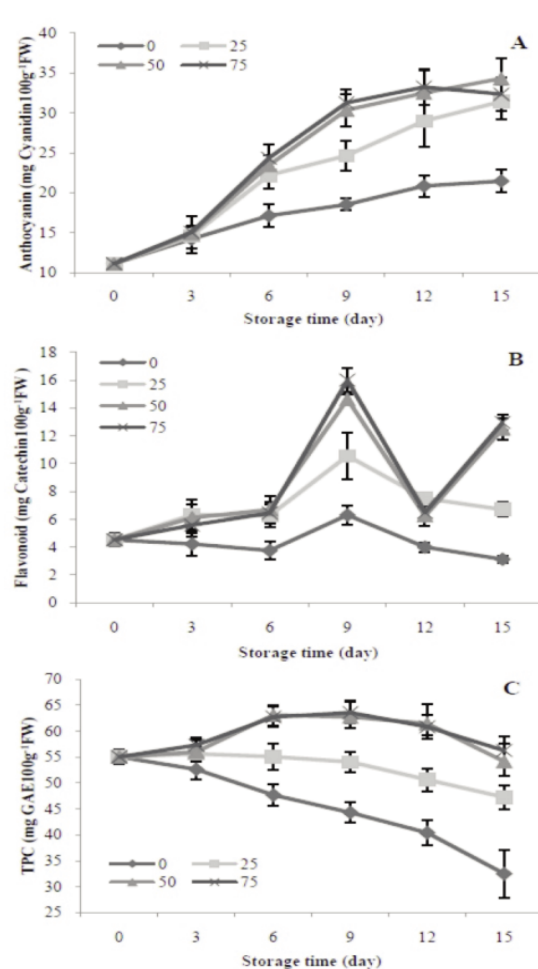
Fig. 2 ­ Anthocyanin (A), flavonoid (B) and total phenolic concen­ trations (TPC) (C) values in figs ( Ficus carica L.) ‘Siyah’ fruit treated with Aloe vera gel (0, 25, 50 and 75%). Fruit were stored at 2°C. Vertical bars represent standard error of means of three experiments with four replicates per